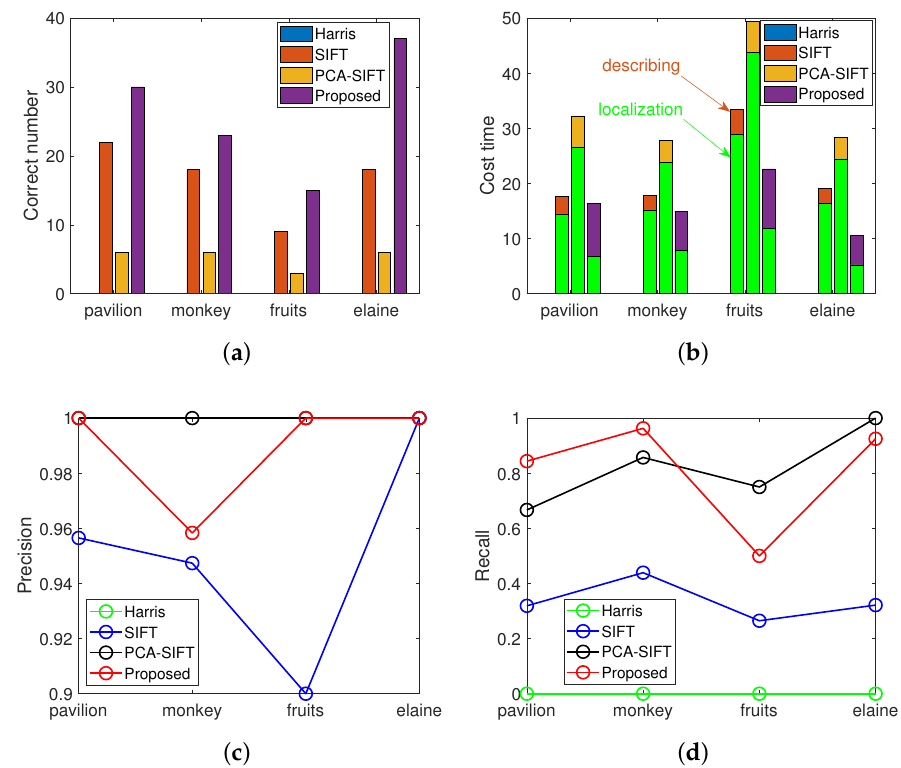
Figure 11. Results analysis of the scaled and rotated images matching test: ( a ) correct matching number; ( b ) cost time per match; ( c ) precision of the matches; ( d ) recall of the matches.